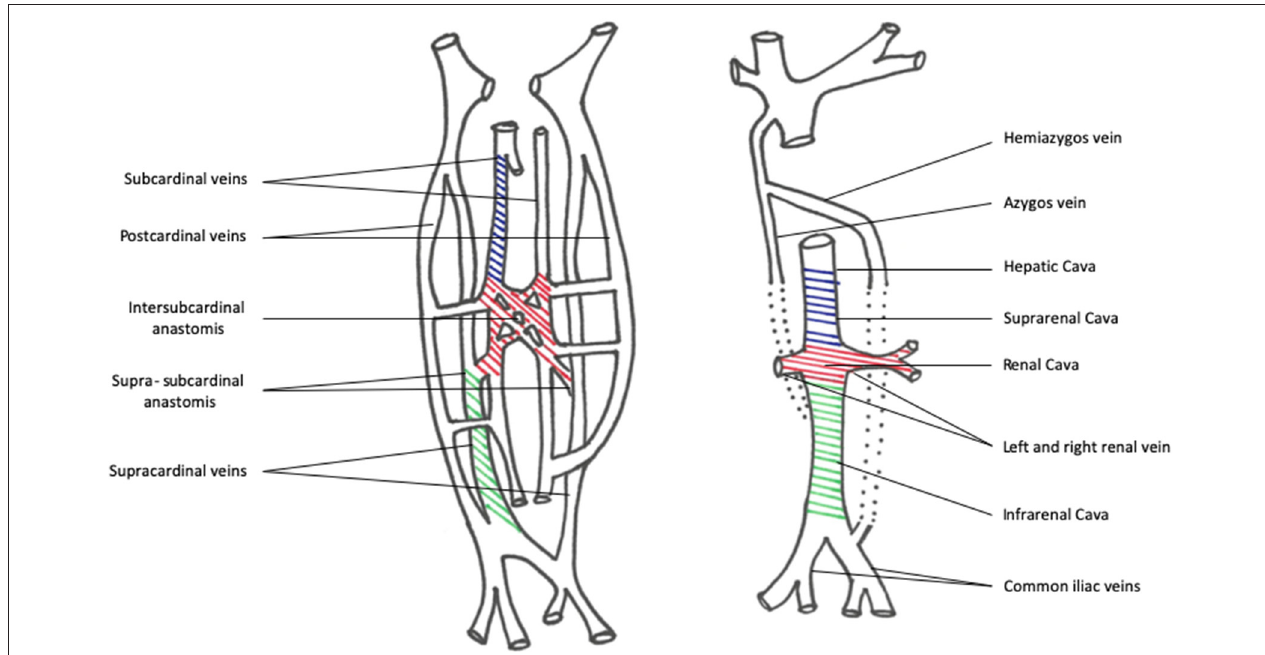
FIGURE 3 | Picture of embryological development pathway of the IVC system. On the left, the schematic configuration highlights the embryological precursors of the IVC: blue indicated the subcardinal veins system; red indicates the Intersubcardinal network anastomosis; green indicates the supracardinal veins. After a complex development and regression process, they give origin to the final suprarenal cava, renal cava, and infrarenal